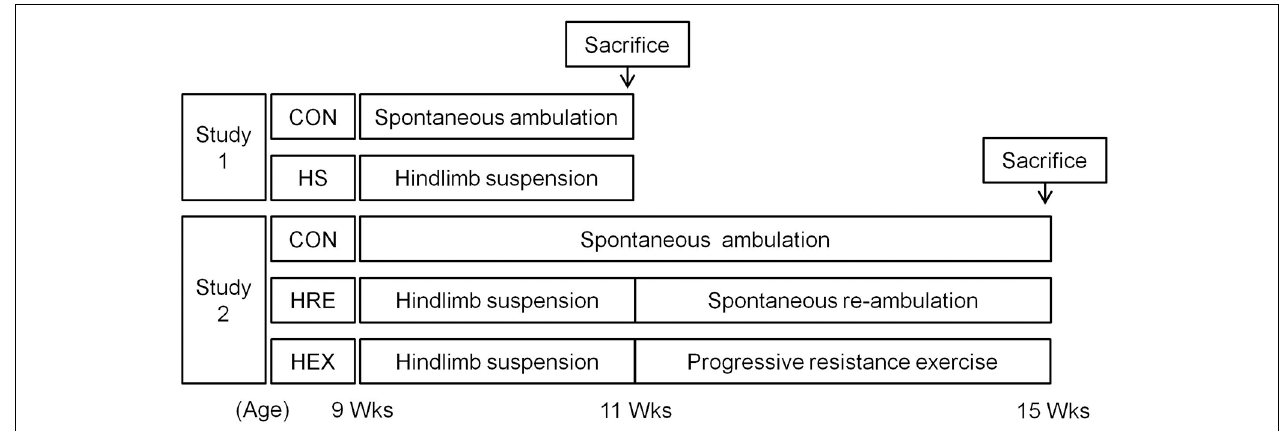
FIGURE 1 | Schematic diagram of study